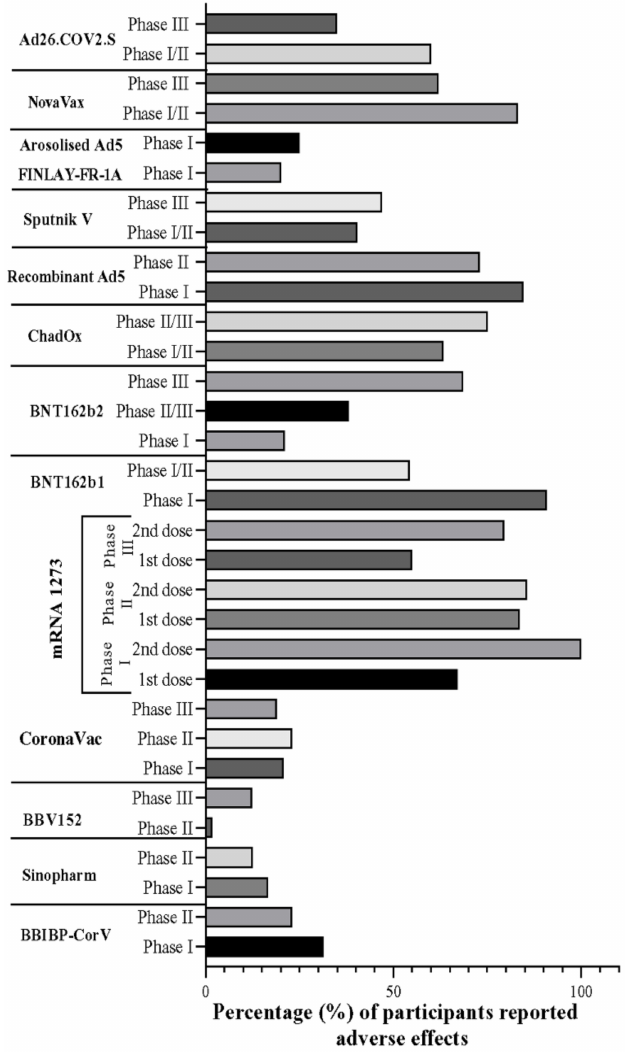
Figure 5. Adverse effects (AE) of several SARS-CoV-2 vaccines by trial phase (i.e., Phase I/II/III), dose number (i.e., 1st or 2nd dose). Data were extracted from the included articles which were selected for this systematic review